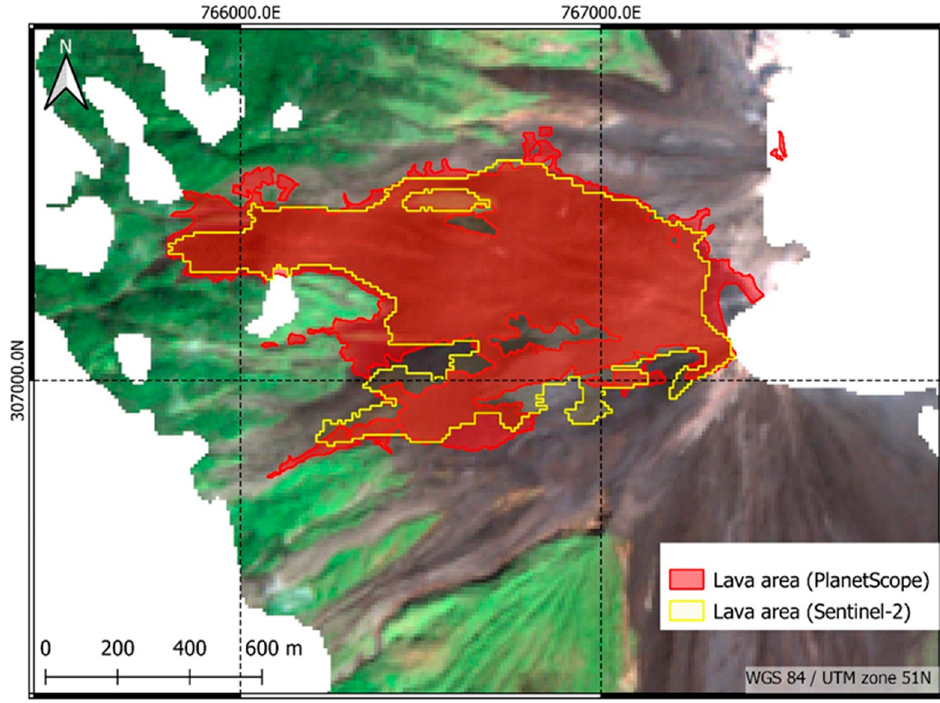
Figure 13. Lava areas derived from PlanetScope and Sentinel-2 data for the Karangetang II erup-tion event. Both lava flows were classified under the same conditions using the OBIA change detection methodology based on dNDVI and NHI. A pre- (9 May 2019) and post-scene (4 December 2020) were used for classification and modelling using Sentinel-2. The results with the 10 m Sentinel-2 imagery are also satisfactory. However, marginal areas to the N of the surface are recorded much more coarsely. In the S of the lava field larger differences to the PlanetScope derived lava area were detected. Due to the lower resolution, the GLCM differences could possibly not detect detailed differences between the objects, which is why the lava areas appears somewhat coarser here.